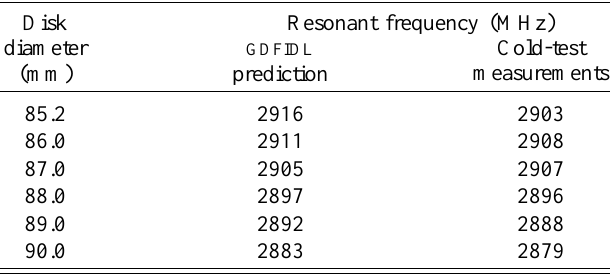
TABLE II. Comparison of predicted and measured resonant frequencies as a function of the disk diameter. Disk Resonant frequency (MHz) diameter GDFIDL Cold-test (mm) prediction measurements